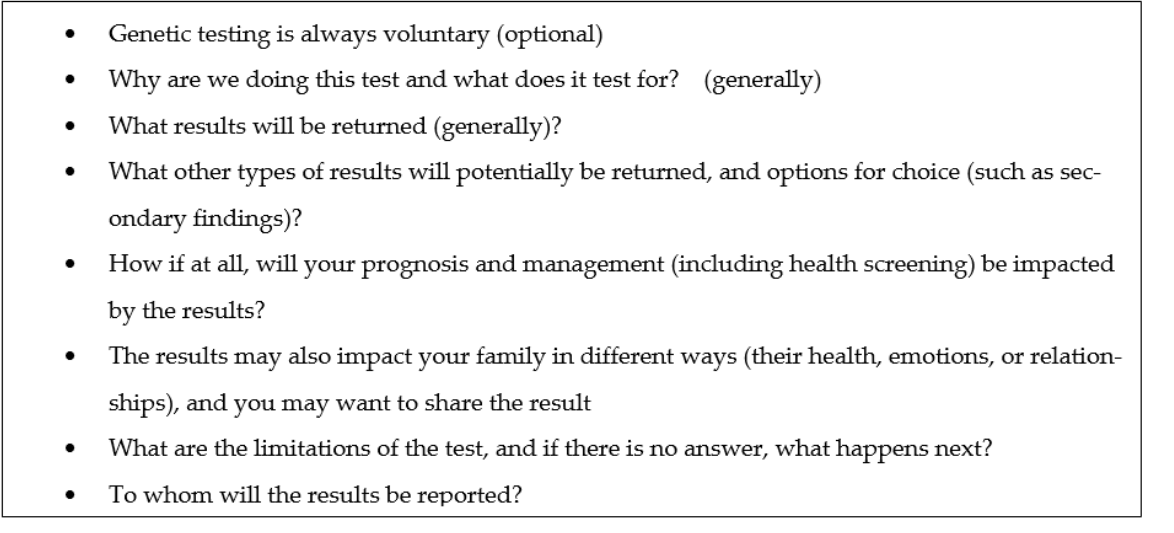
Figure 1. Final list of “necessary and critical” concepts for informed consent for genetic testing.